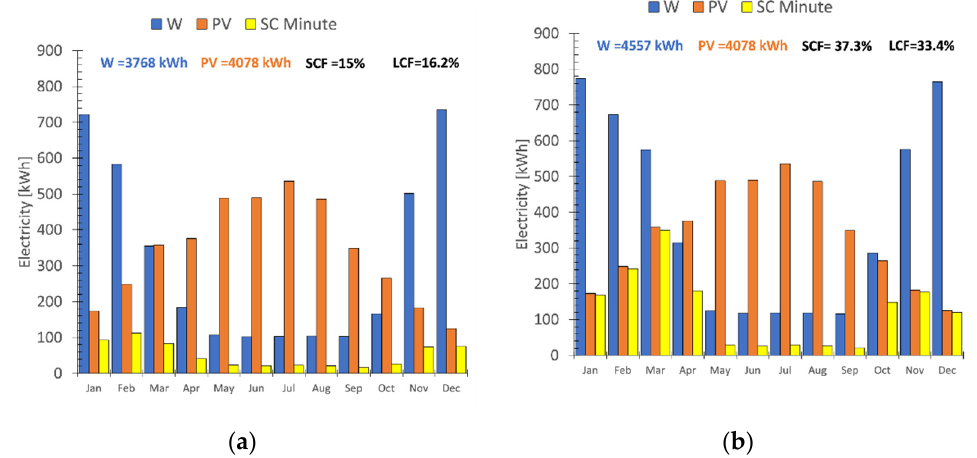
Figure 7. Monthly trends in W, PV and self-consumption in the no appliance case with standard control ( a ) and with rule-based control ( b ).